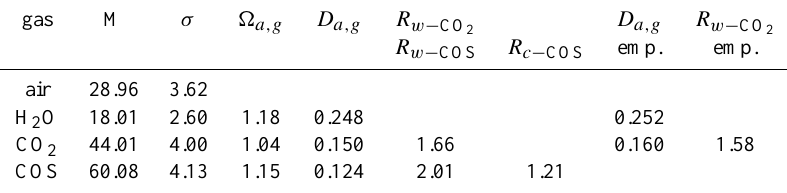
Table 1. Theoretical values of diffusivities D a,g (cm 2 s − 1 ) of water vapour, CO 2 and COS in air (parameters taken from Bird et al., 2007). Empirical estimates of D a,w and D a,c from Massman (1998). All estimates were derived for a temperature of 23C, the average air temperature during the chamber experiments. For plants at typical field conditions, the effect of temperature on the ratios of diffusivities is probably